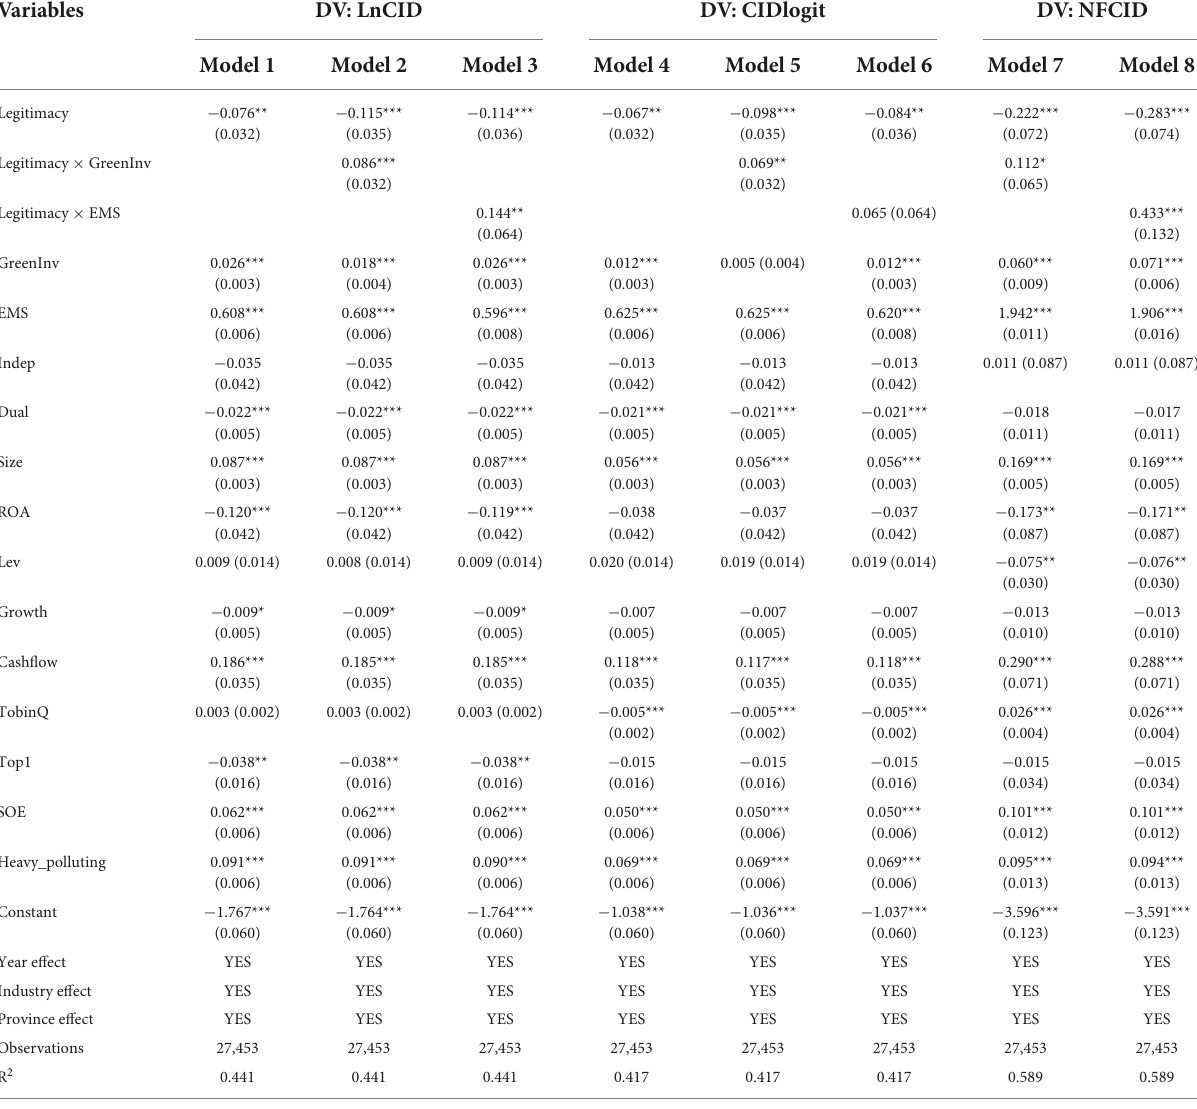
TABLE 6 Robustness check using alternative dependent